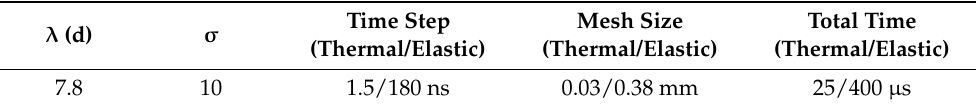
Table 2. Simulation model parameters.